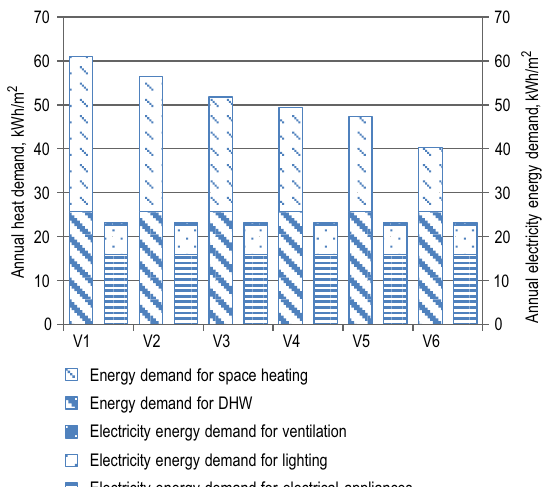
Fig. 4. The energy balance of the low energy